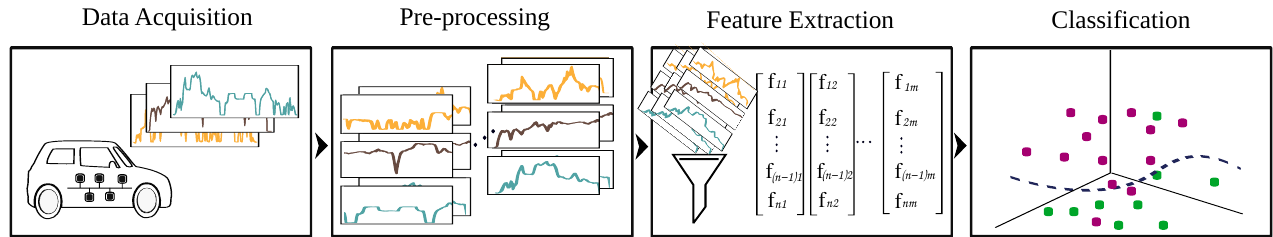
Figure 1. Machine learning framework for accident detection. First, time-series data is being ac- quired from in-car network signals. After pre-processing and segmentation, different feature ex- traction approaches are applied and compared. Finally, classifiers are trained and tested on the extracted